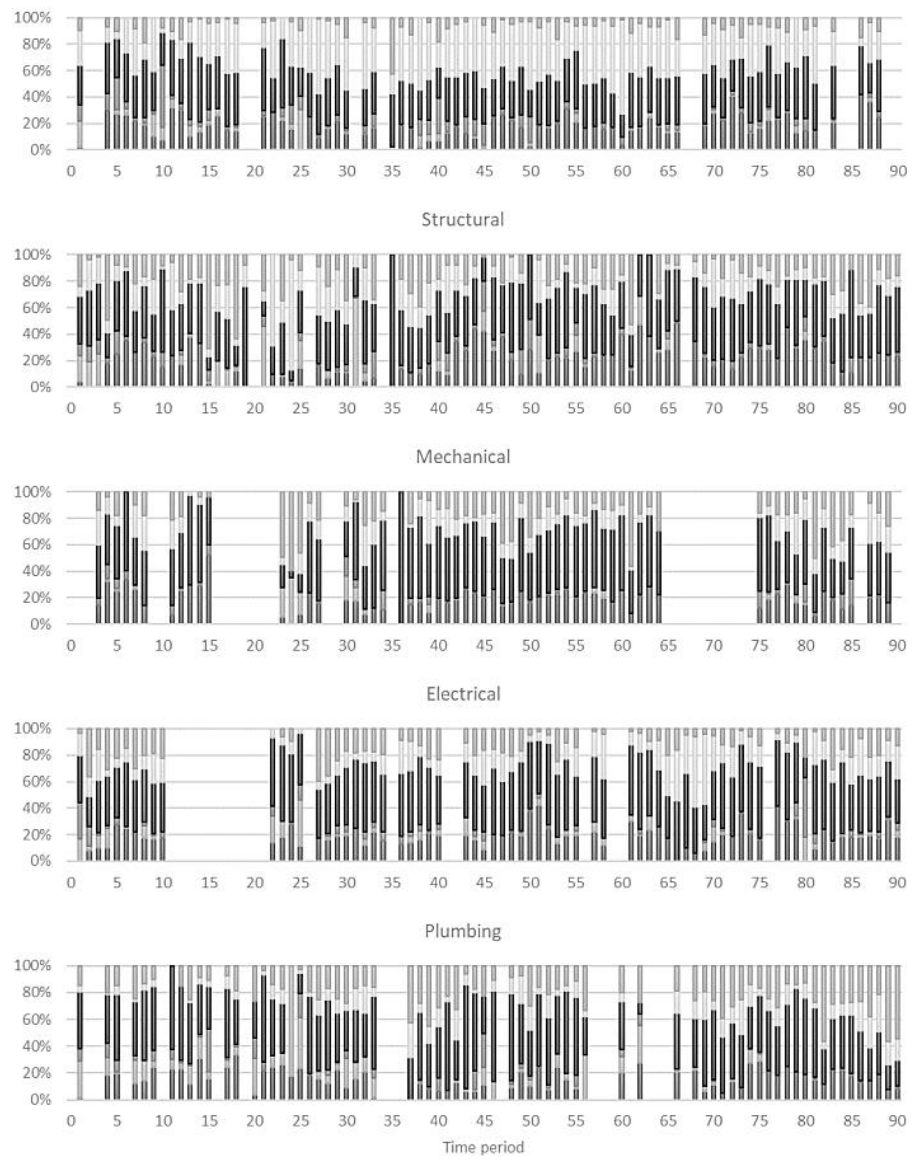
Figure 7. Share of commands by sub-category and time period for each designer.